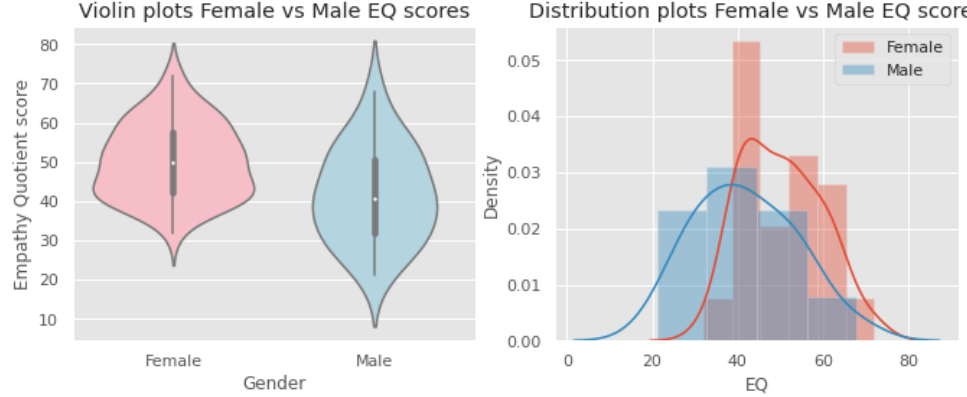
Figure 6. Violin plots ( left ) and distributions ( right ) of EQ scores for males and